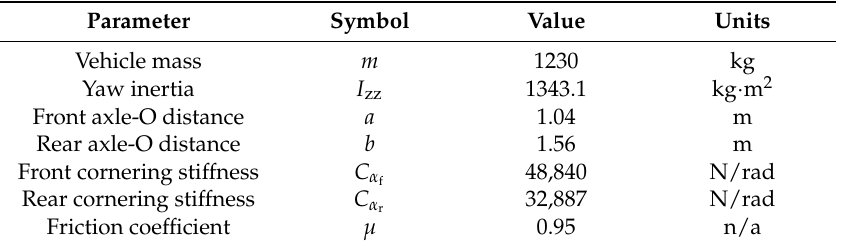
Table 1. Parameter values of the vehicle.